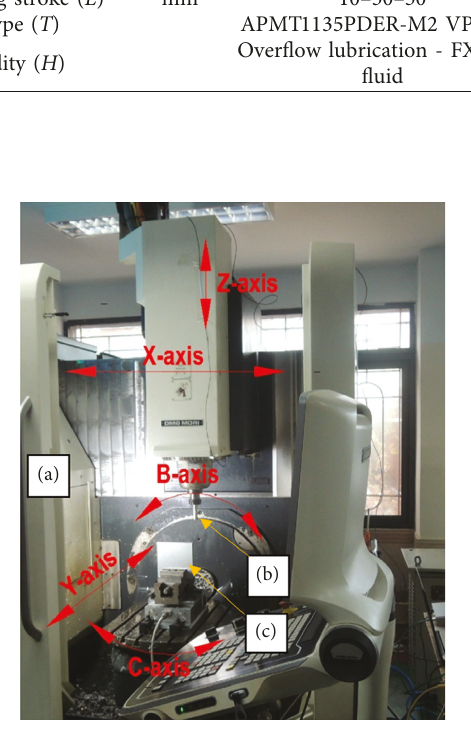
Figure 4: Experimental setup: a: DMU 50 CNC milling 5-axis machine; b: tool; c: workpiece (with permission from [2] (open